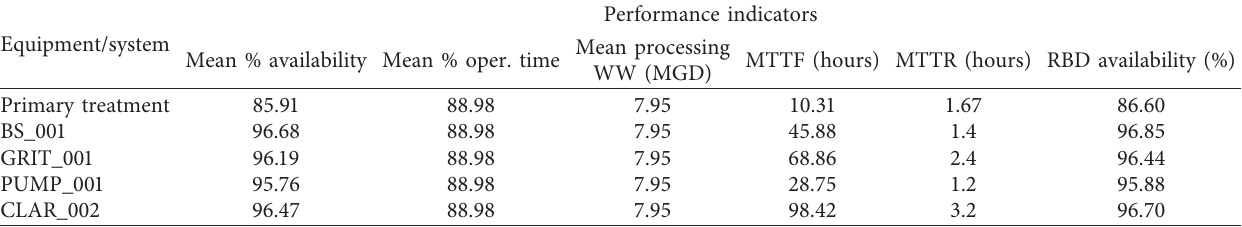
Table 5: Simulation results-VSB scenario. Performance indicators